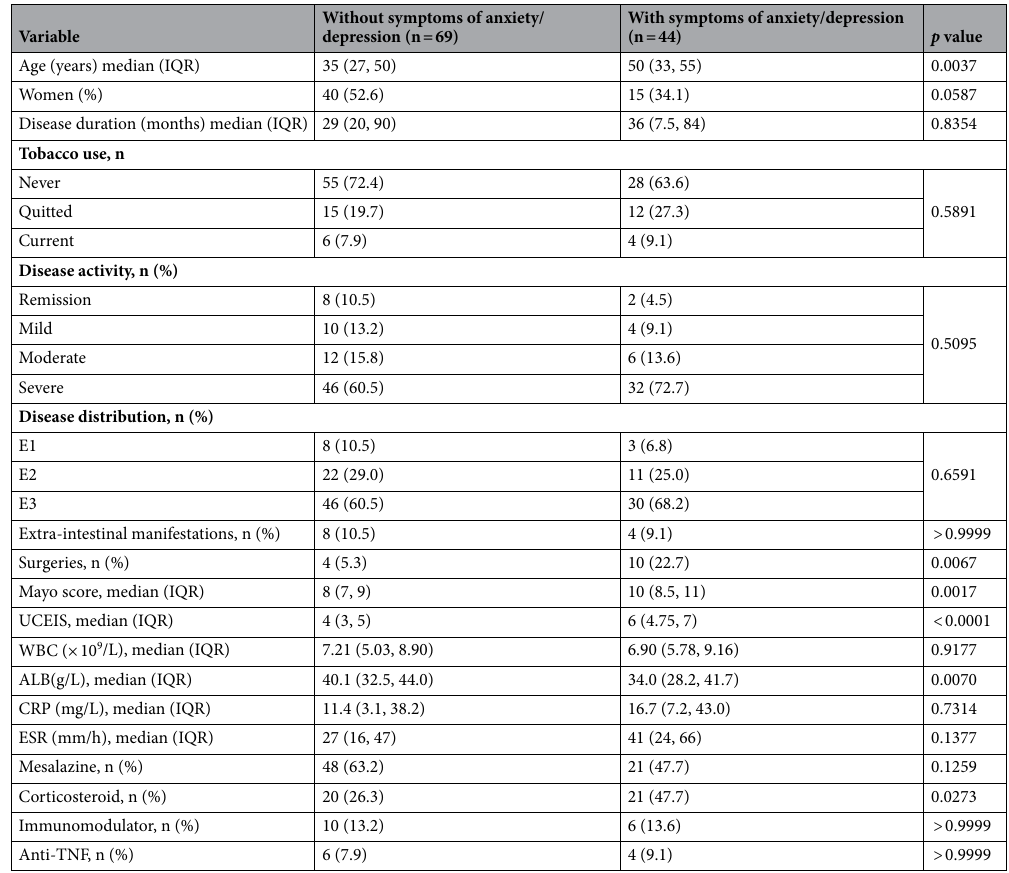
Table 3. Characteristics of the UC cohort. UC ulcerative colitis, UCEIS ulcerative colitis endoscopic index of severity, WBC white blood count, ALB albumin, ESR erythrocyte sedimentation rate, CRP C-reactive protein, TNF tumor necrosis factor, IQR interquartile range.